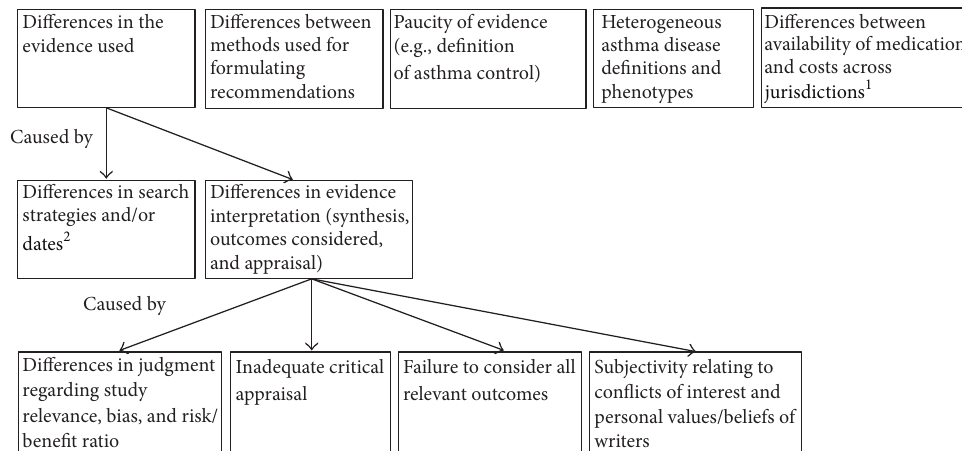
Figure 2: Possible Reasons for observed differences between international asthma guidelines. (1) This is believed to be unlikely to explain the differences between the 3 guidelines in this analysis. (2) This was found to be unlikely to explain the differences between the 3 guidelines found in this